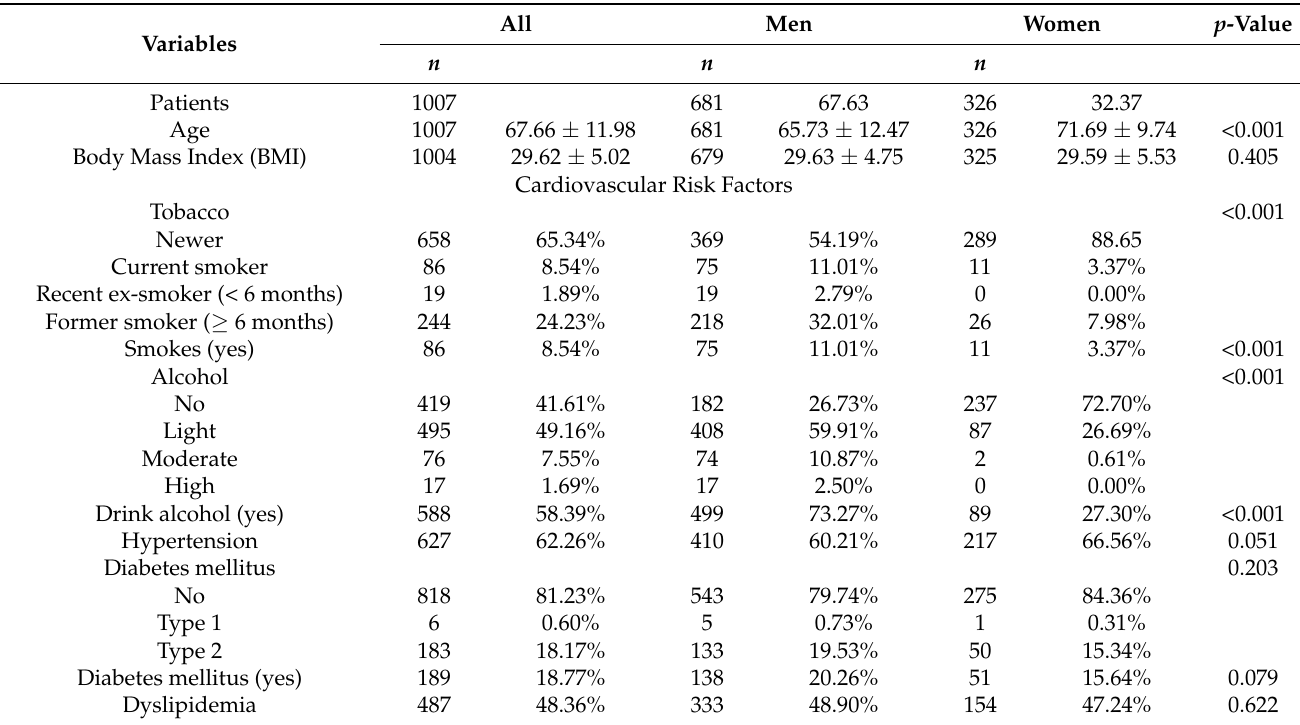
Table 9. Basal characteristics of women and men subjected to rhythm control (RhC) versus rate control